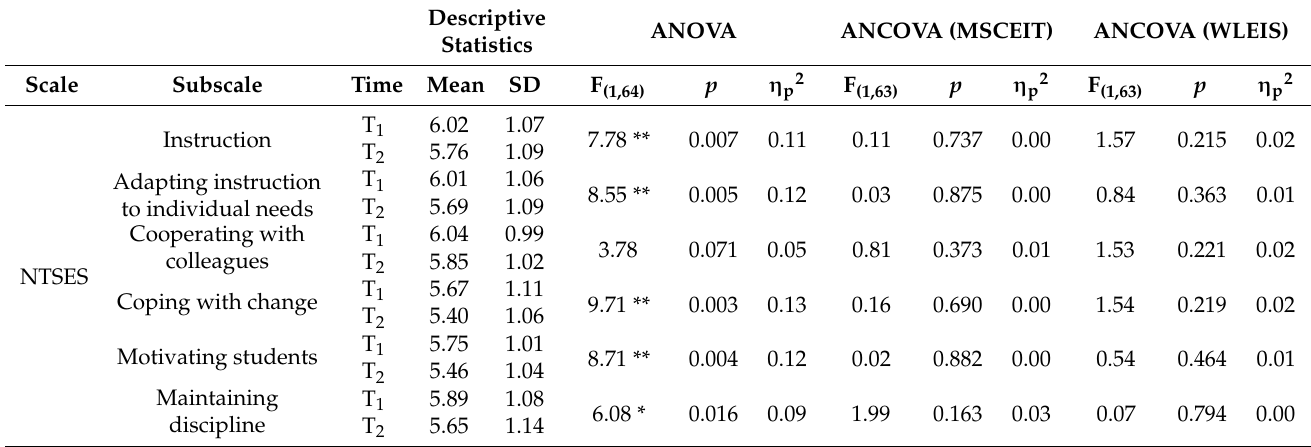
Table 4. Repeated measures ANOVA and ANCOVA results for